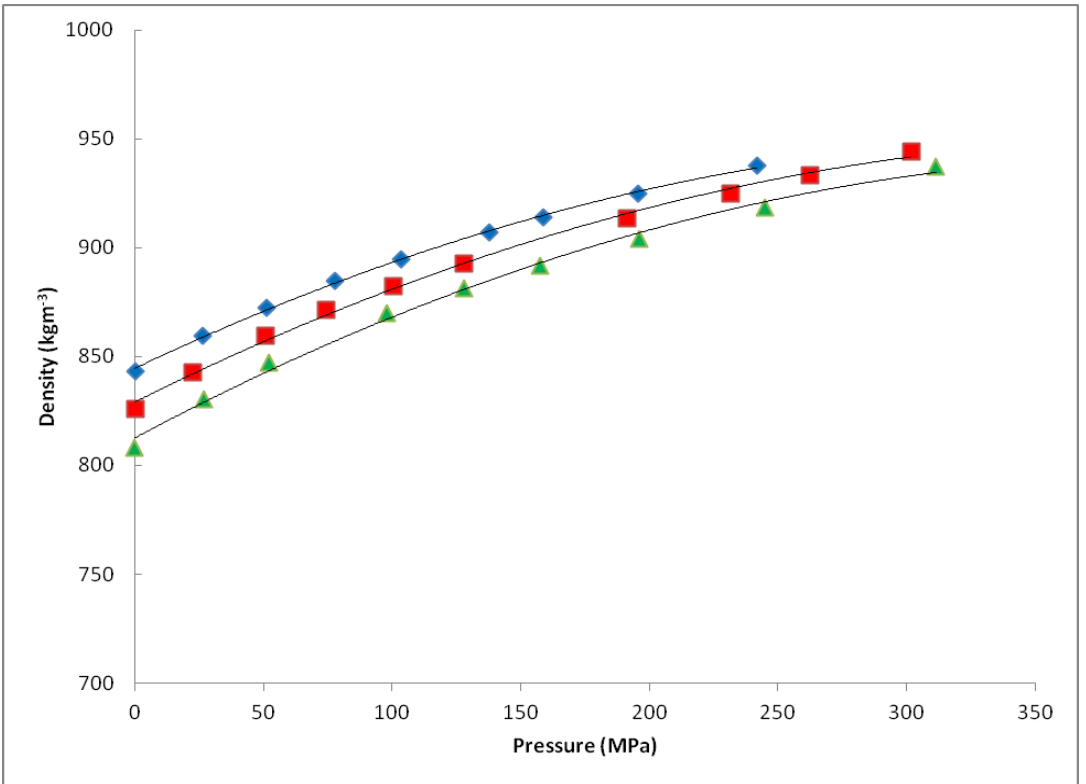
Figure 11. Variation of density for Fuel 5 with temperature. ♦ 298 K, ■ 323 K, and ▲ 348